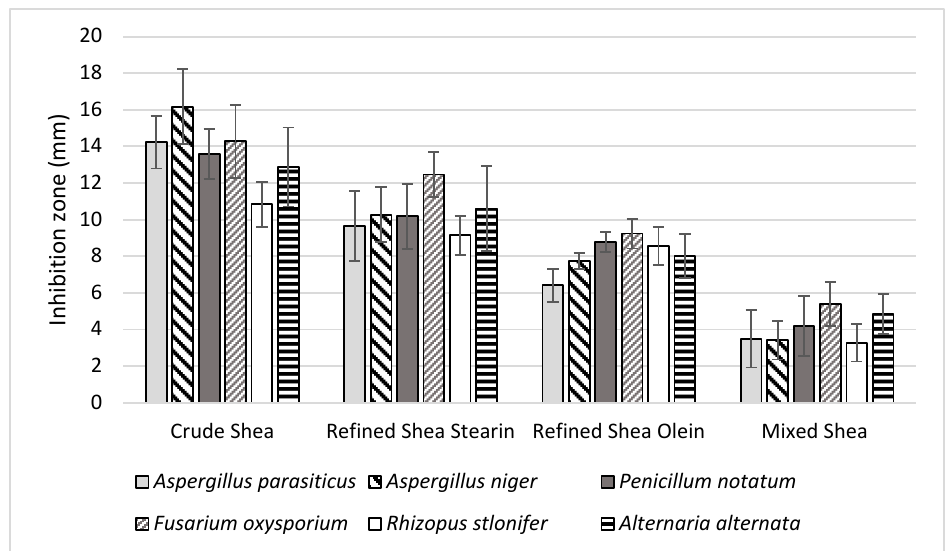
Figure 3. Antifungal activity of crude shea bu tt er, re fi ned shea stearin, re fi ned shea olein and a mixture of olein:stearin (1:1 w / w ) determined against toxigenic fungal strains. The results are expressed as mean percentages ± SD; ( n = 3; p ˂ 0.05).